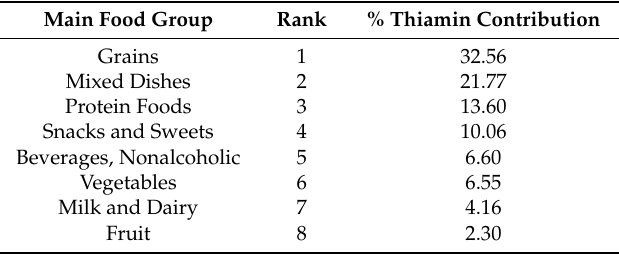
Table 17. Food sources of thiamin contribution in the total U.S. diet, adults ≥ 51 years old ( n = 4522; gender combined; daily intake data; NHANES 2011–2014; main food groups contributing <1.0% not reported; data are Day 1 intakes).